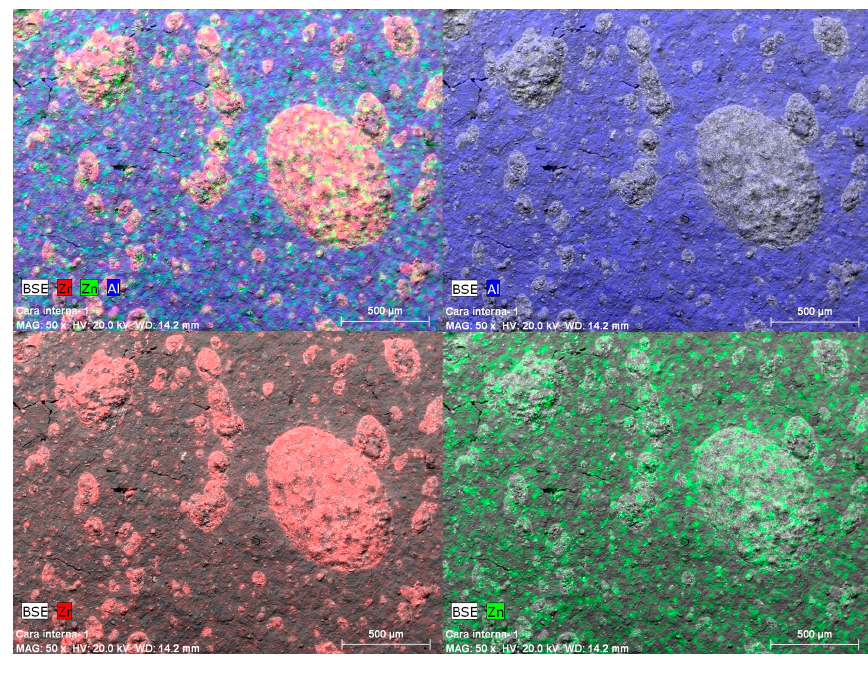
Figure 16. SEM of the ceramic tile’s hidden face. Distribution of Zr, Zn, and Al.